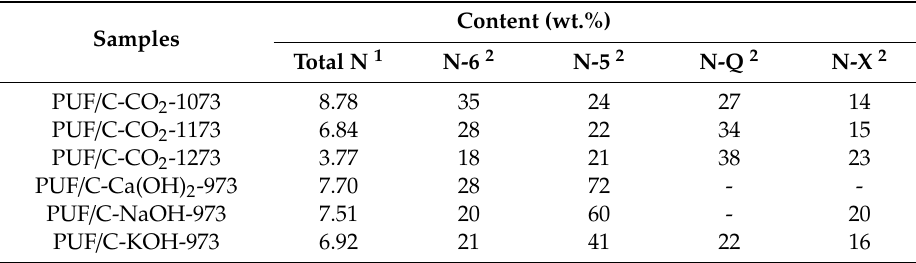
Table 1. Surface nitrogen contents of polyurethane foam-based activated carbons prepared by physical and chemical